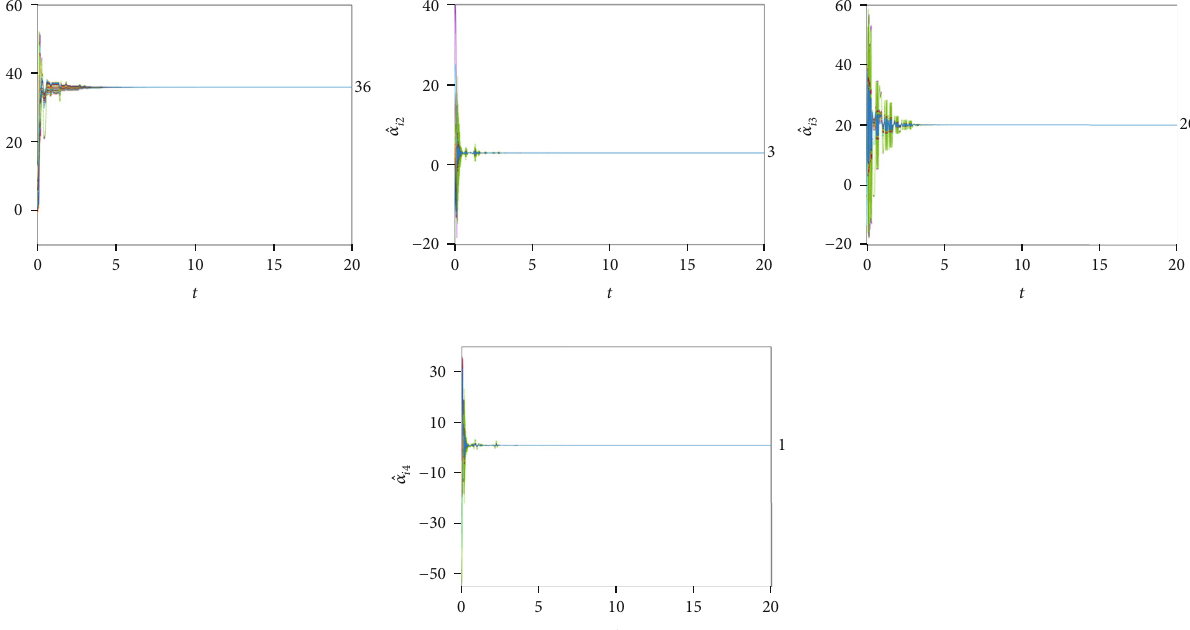
Figure 14: Identi fi cation of the uncertain parameters b α